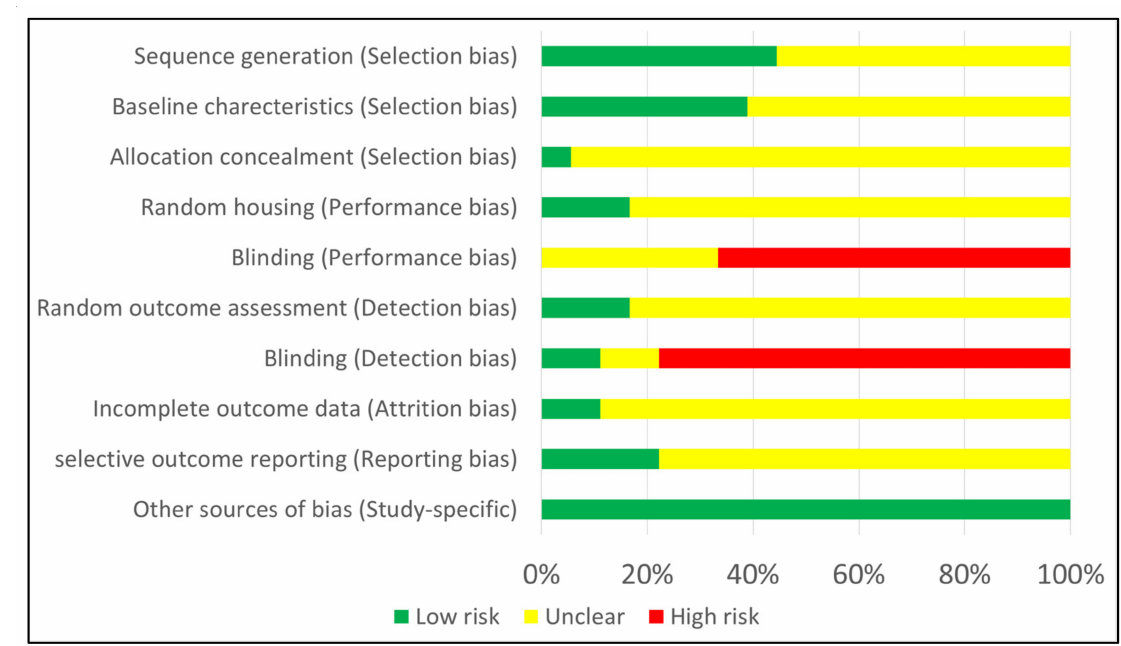
Figure 2. Risk of bias using SYRCLE’s tool for animal